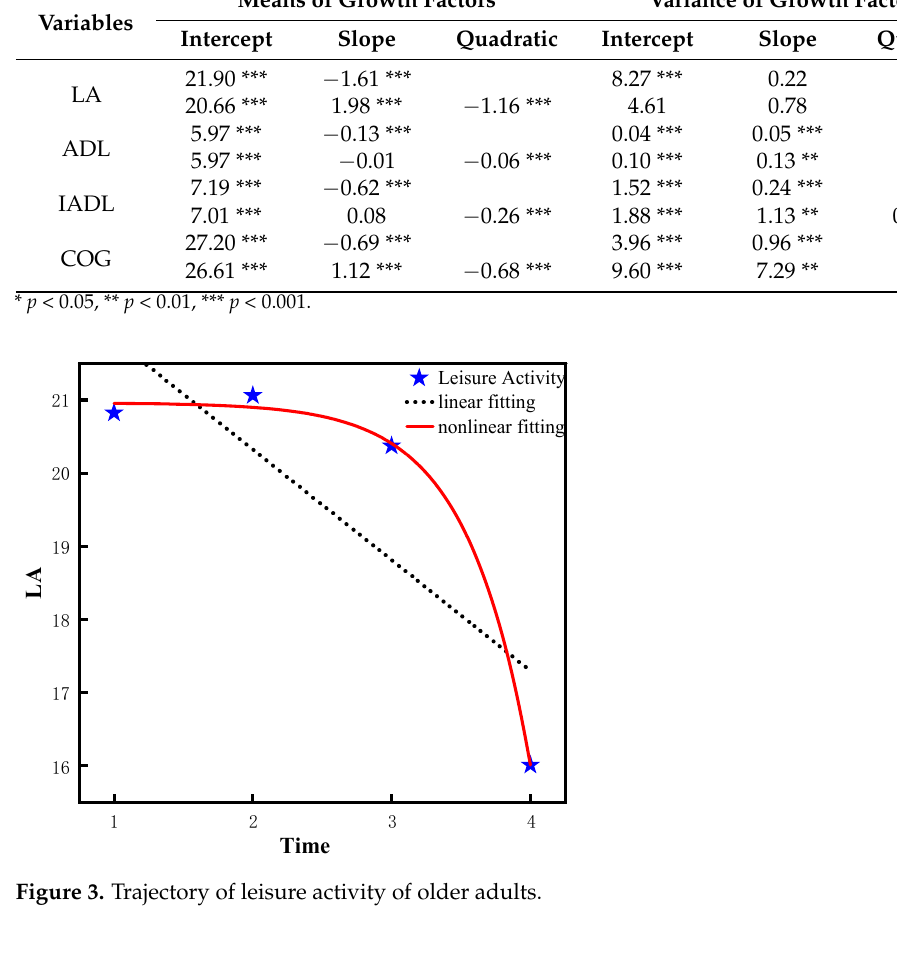
Figure 4. Trajectory of ADL ability of older adults.